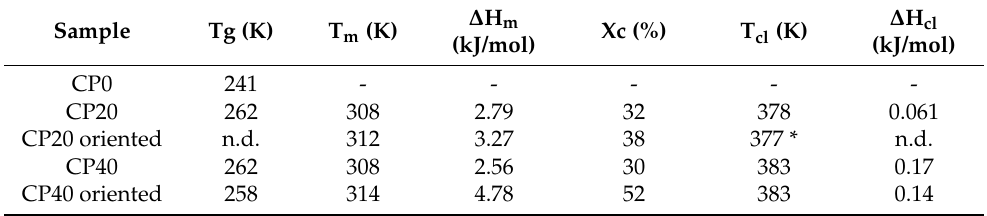
Table 2. Calorimetric characterization of CP0, CP20 and C40. Glass transition (Tg), melting (T m ) and clearing (T cl ) temperatures; melting ( ∆ H m ) and clearing ( ∆ H cl ) enthalpies per mol repetitive unit; crystallization degree (Xc). Data relative to unoriented samples determined from DSC second heat- ing scan.